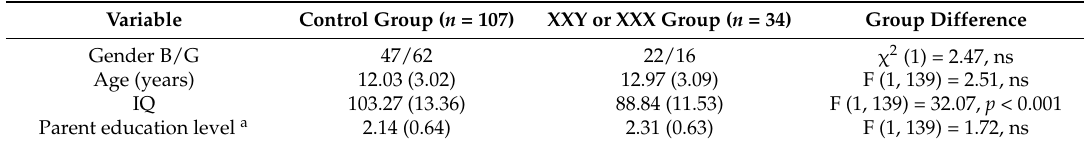
Table 1. Characteristics of the extra X chromosome and the control groups (scores represent means and standard